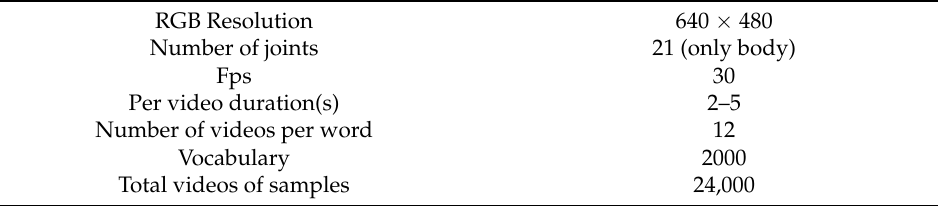
Figure 11. Example of DEVISIGN-L dataset. ( a ) RGB data; ( b ) depth image data; ( c ) Skeleton data. Table 3. Details of the DEVISIGN-L dataset.